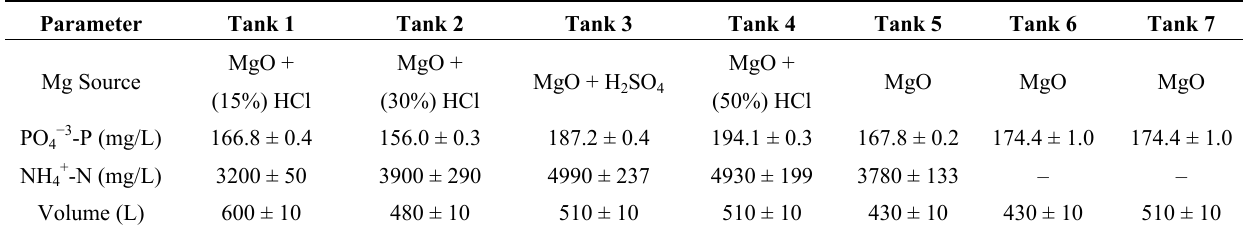
Table 1. Reagents addition in the urine treatment experiments, concentrations of N and P in the stored urine and volume treated in each